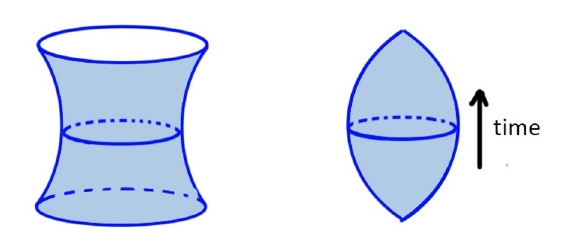
Figure 1 . The Maldacena-Maoz construction. Left: Euclidean AdS wormhole. Right: The analytic continuation to a closed universe big-bang / big-crunch